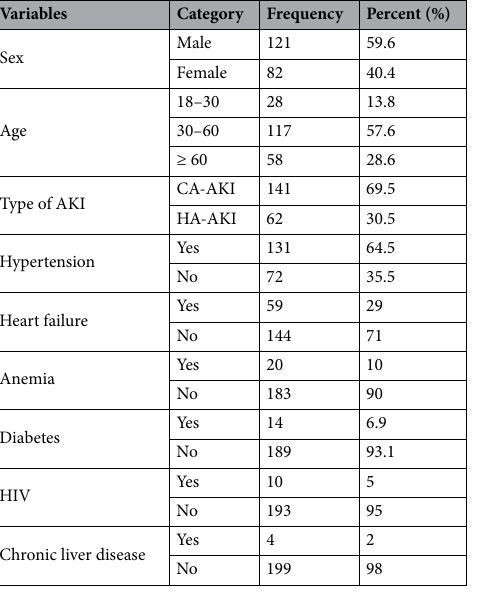
Table 1. Baseline clinical characteristics of AKI patients at JMC (n = 203). AKI, Acute kidney injury; HIV, Human immune virus; HAAKI, Hospital-acquired AKI; CAAKI, Community-acquired AKI; JMC, Jimma Medical